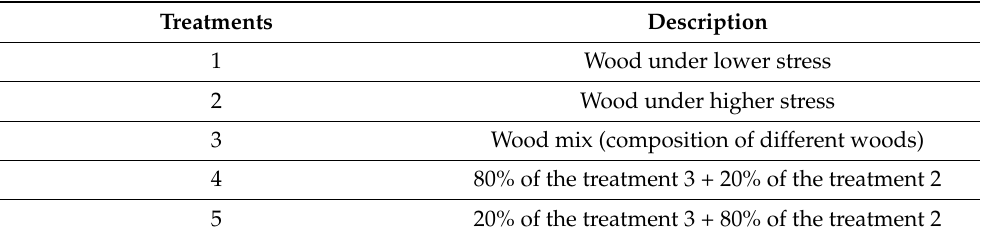
Table 2. Composition of the treatments—wood samples from different levels of stress and mixture used in pulping process.